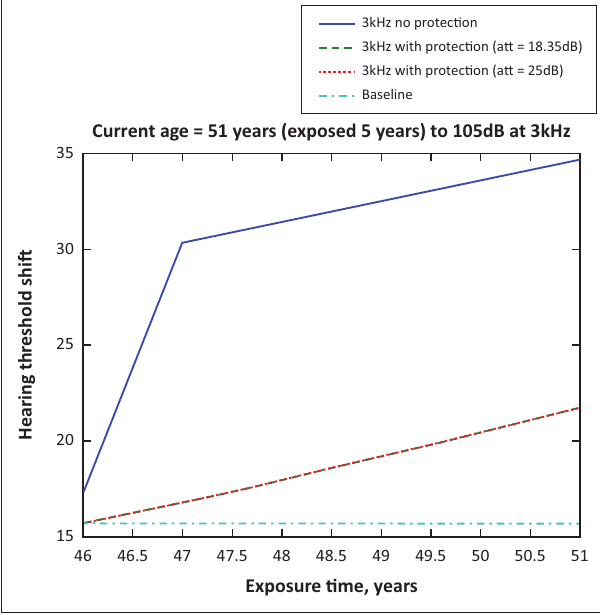
Source : Figure created using data from Moroe, N.F. (2018). Occupational noise-induced hearing loss in South African large scale mines: From policy formulation to implementation and monitoring . Doctoral thesis. Johannesburg: University of the Witwatersrand. FIGURE 14: Fifty-one years old at 3000 Hz with exposure levels of 105 dB.